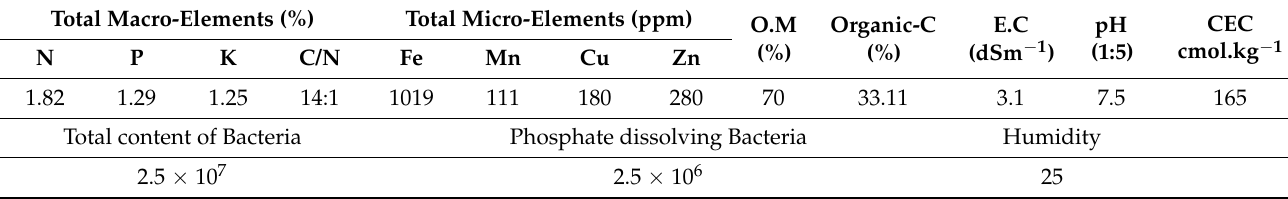
Table 7. The chemical and microbial properties of the applied compost.